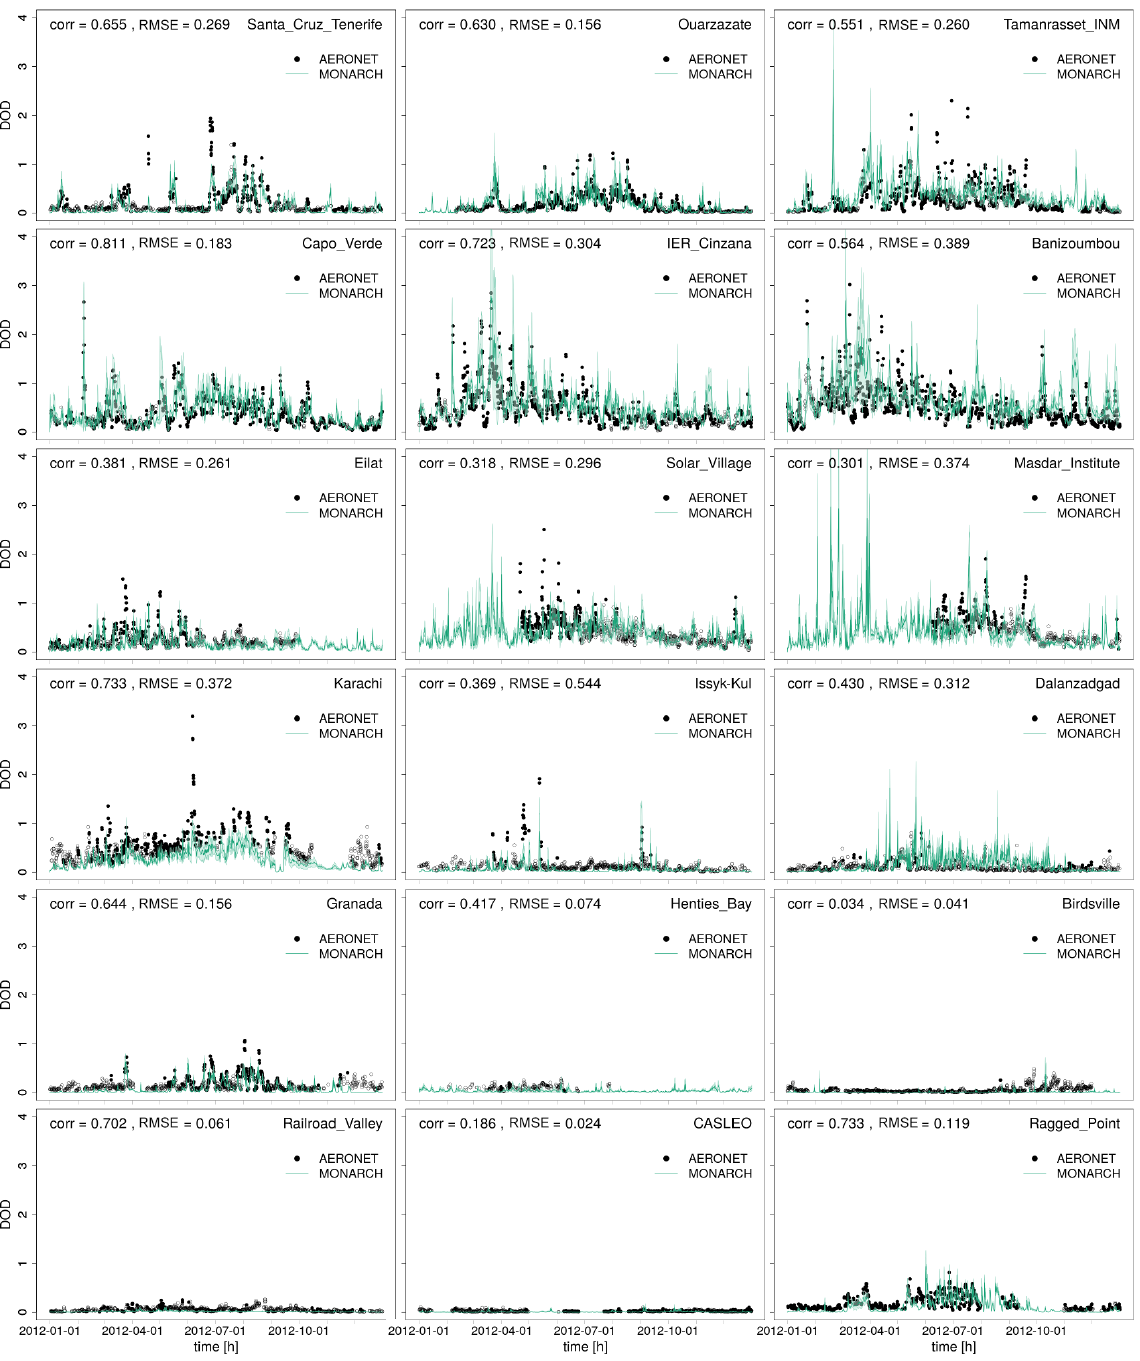
Figure 8. Comparison of 3-hourly DOD between MONARCH (average (turquoise line) and standard deviation (shading)) and AERONET direct-Sun V3 level 2.0 for selected stations covering Cabo Verde and the Canary Islands (Capo Verde, Santa Cruz de Tenerife), the Sahara and Sahel (Ouarzazate, Tamanrasset, Cinzana, Banizoumbou), the Middle East (Eilat, Solar Village, Masdar Institute), Asia (Karachi, Issyk- Kul, Dalanzadgad), Europe (Granada), southern Africa (Henties Bay), Australia (Birdsville), and North and South America including the Caribbean (Railroad Valley, CASLEO, Ragged Point). The direct-Sun DOD is filtered for dust aerosol using Ångström exponent (AE) < 0 . 3 (filled circles). Records which do not meet the AE criteria are less likely to be associated with dust and are shown as open circles. The Pearson correlation coefficients (corr) and RMSE are given in each